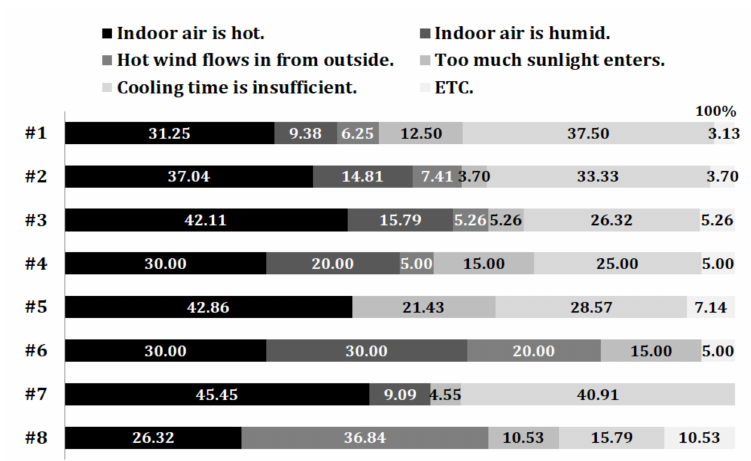
Figure 2. Dissatisfactory cause of winter.